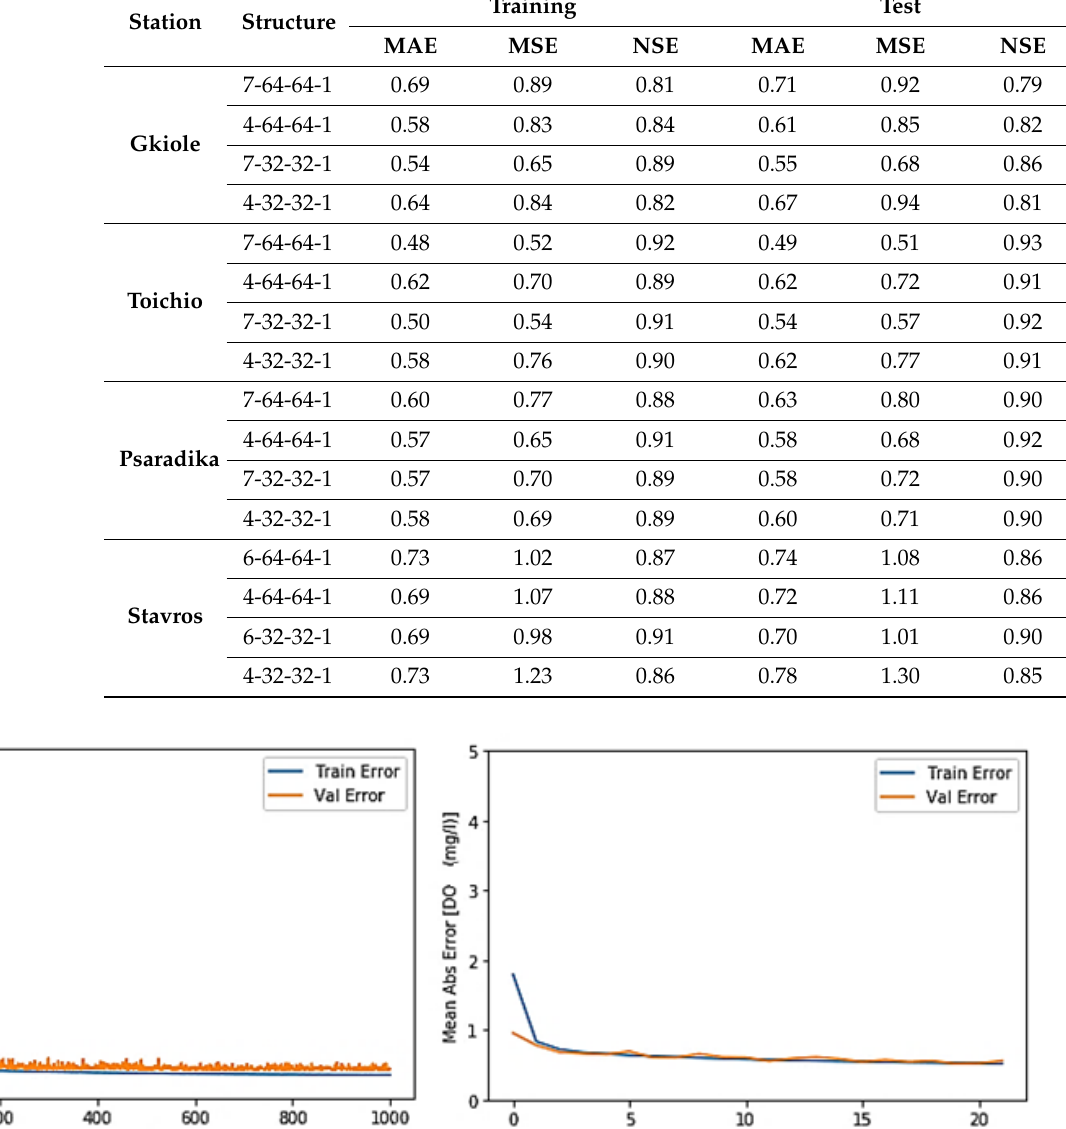
Table 3. Statistical descriptors of the investigated structures for all stations.